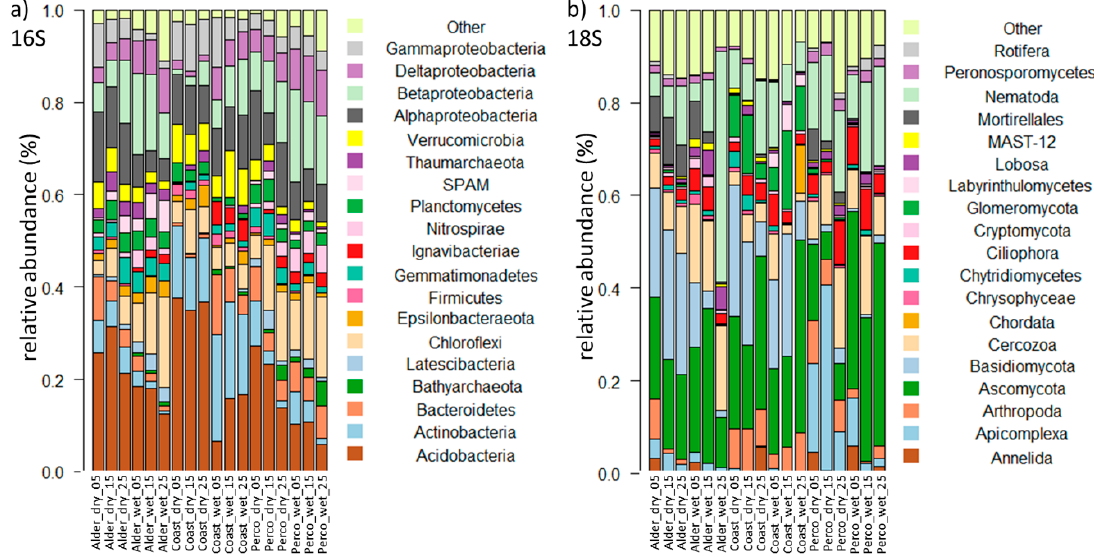
Figure 3. Composition of prokaryotic and eukaryotic microbial communities of drained and rewetted fens. ( a ) Taxonomic composition of prokaryotic 16S rRNA genes displayed at the phylum level, with Proteobacteria shown at the class level. ( b ) Taxonomic composition of eukaryotic 18S rRNA genes, at the phylum level. Bars show triplicates of cores; phyla with < 1% abundance are displayed as “other”. The sample ID on the x-axis displays fen type and depth in cm.